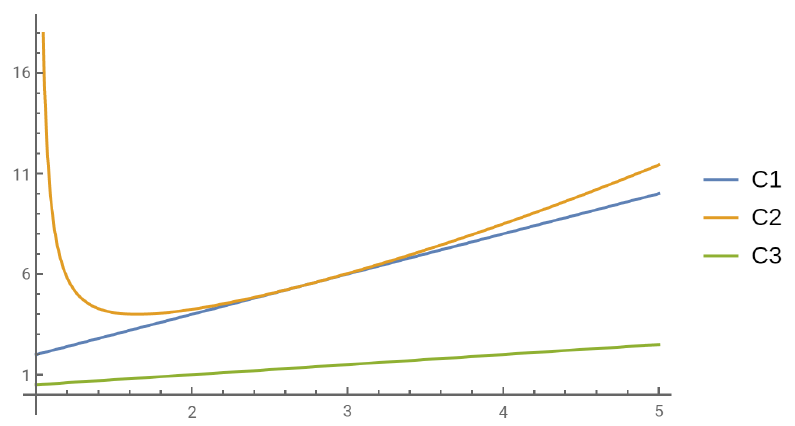
= 0.25, and p ∗ = 0 2 1